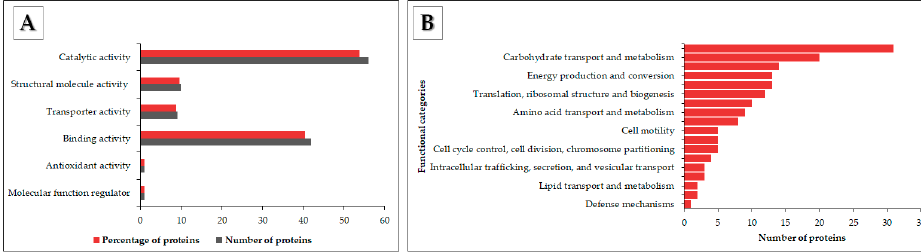
Figure 5. OMV protein molecular functions and protein COG classification. ( A ). The graph shows the molecular ontology entries against the number and percentage of associated proteins. ( B ) The chart shows protein functional group categories and the corresponding number of proteins associated with each cluster.